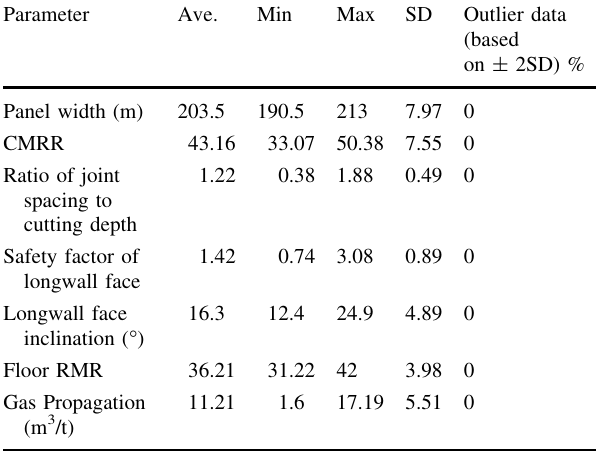
Table 8 Description of average amount of parameters for considered panels in Parvadeh-I coal mine (remove outlier data from basic